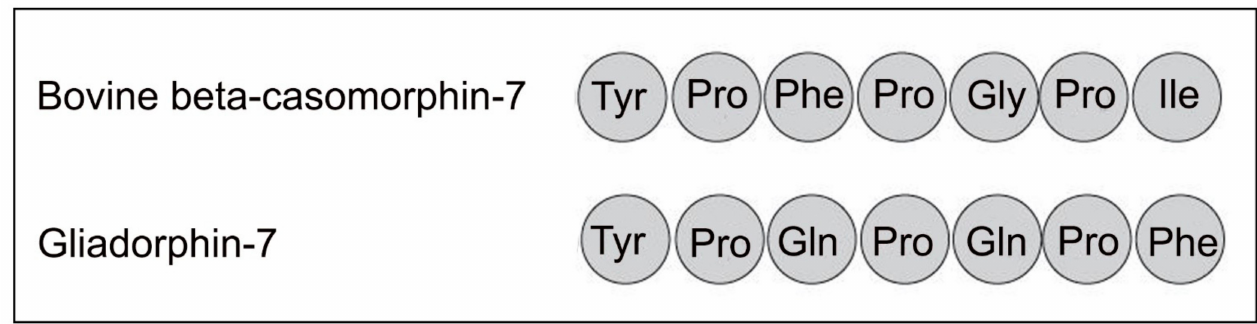
Figure 3. Comparing bovine beta-casomorphin-7 and